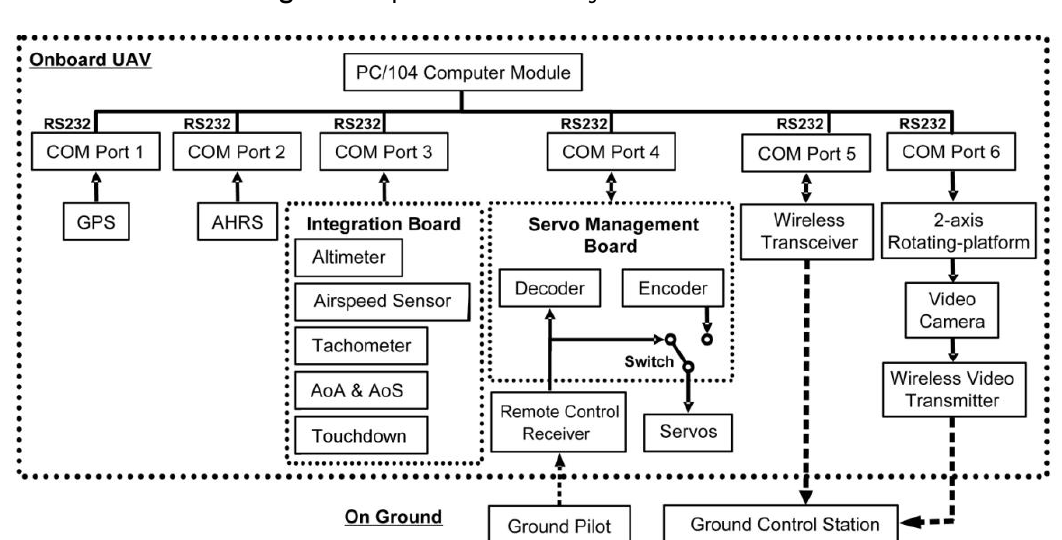
Figure 3. Spoonbill UAV System